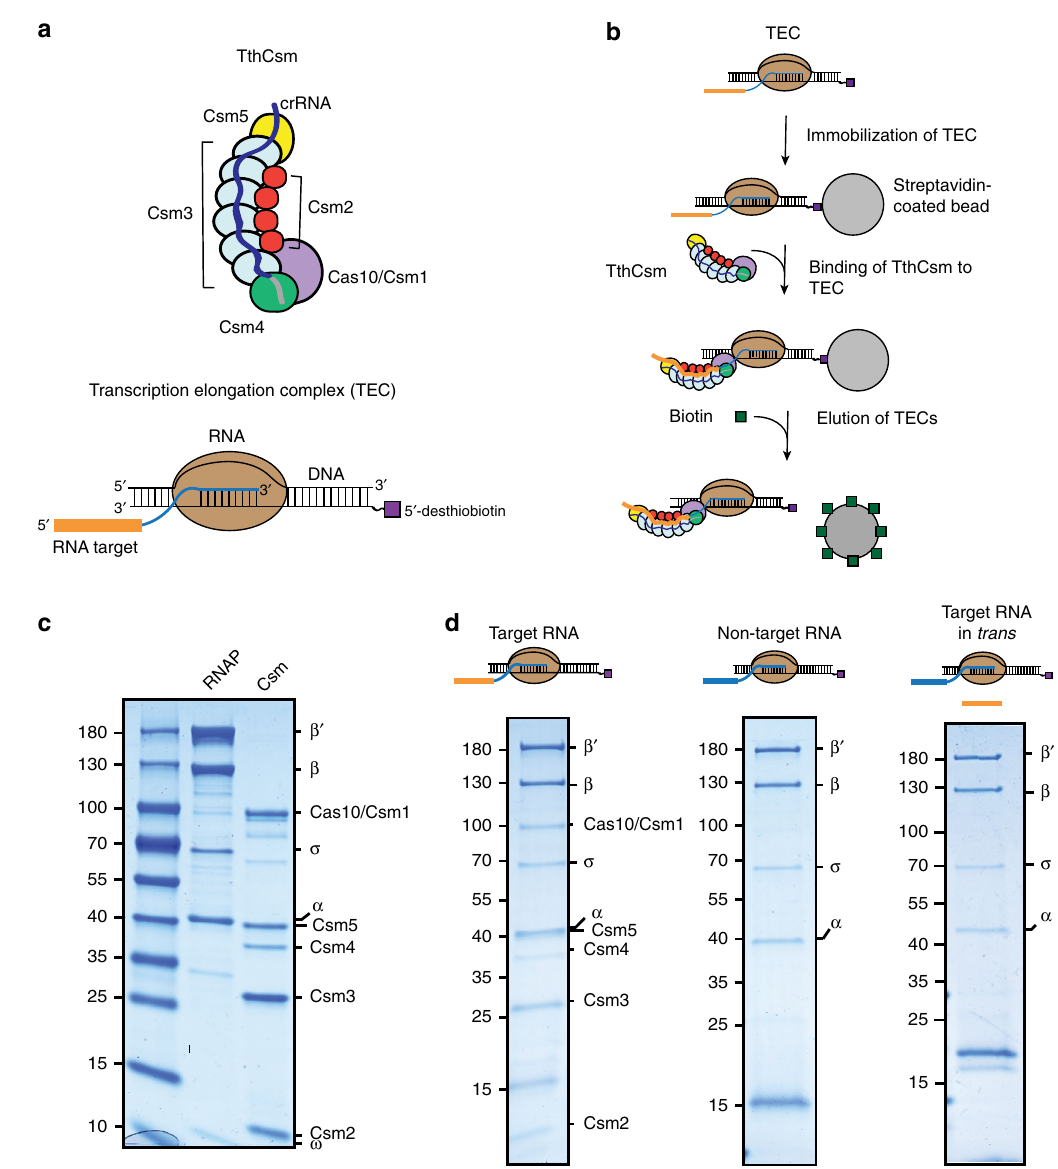
Fig. 1 Tethering of TthCsm to a transcription elongation complex (TEC) by a complementary nascent RNA transcript. a Schematic of the TthCsm complex and the TEC. TthCsm subunits are labeled. RNAP; RNA polymerase. The sequence in the RNA transcript that is complementary to the crRNA in TthCsm is highlighted in orange. A 5´-desthiobiotin moiety on the template strand of DNA in the TEC is labeled. b Schematic of the pull-down assay. The TEC was immobilized on streptavidin beads using a desthiobiotin group on the DNA. TthCsm was incubated with the TEC, after which the beads were washed to remove unbound complexes, and biotin was added to elute the TECs from the beads. c Sodium dodecyl sulfate polyacrylamide gel electrophoresis (SDS- PAGE) of the puri fi ed T. thermophilus RNAP ( α , β ´, β , σ , ϖ ) and TthCsm (Cas10/Csm1, Csm2-Csm5) complexes. A molecular weight marker was run for comparison in the leftmost lane and sizes are indicated in kilodaltons. d Pull-down assays were done with TECs containing a target (left), non-target (middle), or target RNA transcript added in trans (right). The elutions were analyzed by SDS-PAGE. The presence of RNAP and TthCsm subunits is indicated. The positions of the molecular weight markers in ( c ) are shown. Uncropped gel images for ( c , d ) are available online in the Source Data fi (Supplementary Fig. 3a). Electrophoretic mobility shift experi- did not observe density corresponding to ssDNA in the DNase ments (EMSAs) showed that a small, fi xed amount of radi- subunit, Cas10/Csm1, consistent with the low af fi nity of TthCsm olabeled ssDNA was not fully bound by TthCsm at for ssDNA (Supplementary Fig. 3b ) . This subunit stoichiometry is concentrations up to 10 µM (Supplementary Fig. 3b ) , indicating similar to that of a TthCsm complex determined previously by TthCsm has a weak af fi nity for ssDNA. A 3D reconstruction of native mass spectrometry, with the exception of a missing the TthCsm sample (3.8 Å resolution), which contained both Csm5 subunit 9 . The additional density at the top of the TthCsm complex likely corresponds to Csm5 but could not be modeled target RNA and noncomplementary ssDNA, revealed a complex due to poorly resolved density (Fig. 3a). During 3D classi fi cation, comprising one copy each of Cas10/Csm1 and Csm4, six a shorter complex was also observed, which likely corresponds to Csm3 subunits, and four Csm2 subunits bound to a crRNA:target RNA hybrid (Fig. 3a and Supplementary Figs. 3c,d, 4, and 5). Csm2 subunits, as detected previously by native mass Though we added an excess of ssDNA to the TthCsm sample, we